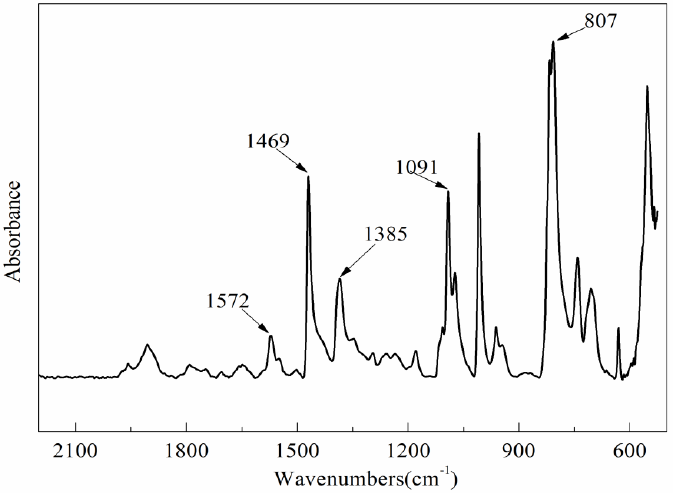
Figure 6. FTIR spectra of pure PPS resin.